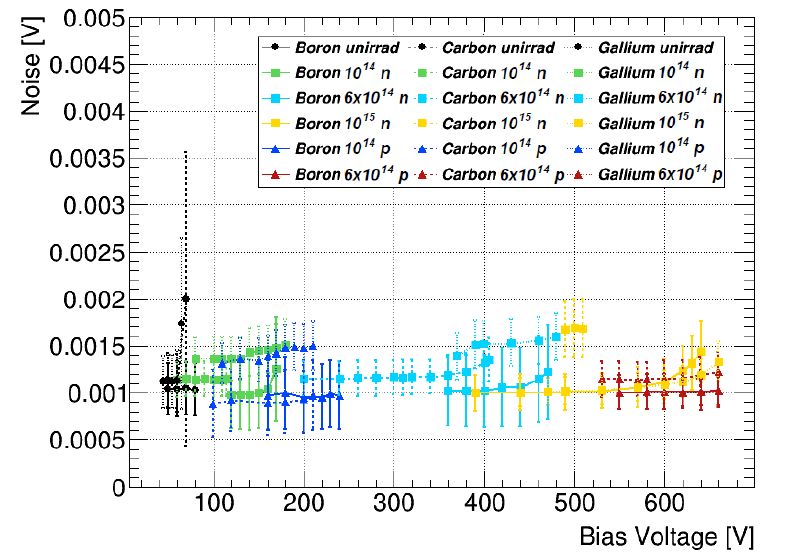
Figure A4. Noise as a function of the bias voltage for CNM LGADs irradiated up to a fluence of 10 15 n eq /cm 2 at − 30°C. The error bars are determined from a Gaussian fit.